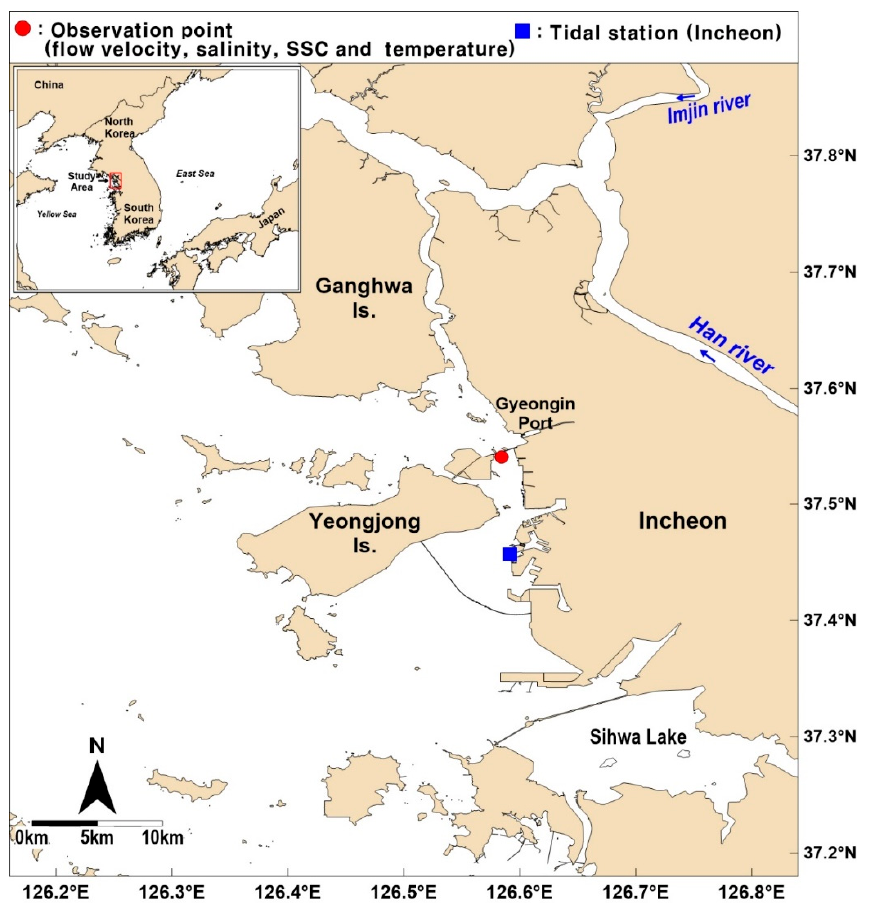
Figure 1. Location of observation point.